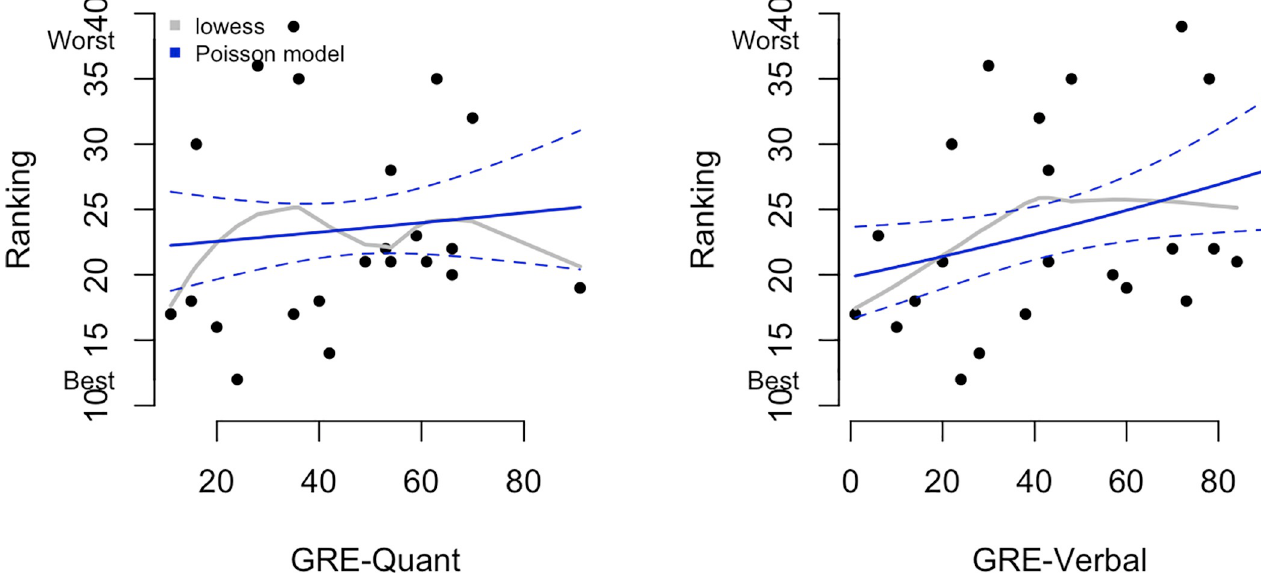
Fig 8. Associations between GRE scores and faculty ranking. Solid curves show the fitted values from the Poisson regression models (dashed lines are 95% confidence intervals) and the grey curves shows lowess smoothers (locally weighted scatterplot smoother).